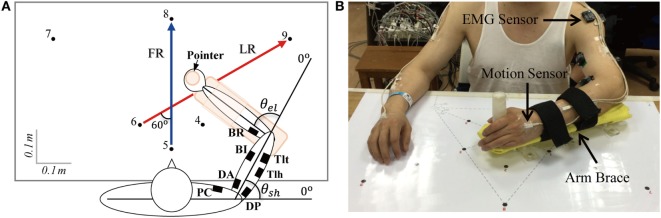
(A) Forward reaching (FR) and lateral reaching (LR) tasks and (B) experimental set up. Subjects moved the pointer from point 5 to point 8 when performing FR and from point 6 to point 9 for LR when the right arm was evaluated (point 4 to point 7 when the left arm was evaluated). Seven channels of electromyography (EMG) were recorded with wireless EMG sensors indicated by filled squares in (A), the recorded muscles were pectoralis clavicular (PC), anterior deltoid (DA), posterior deltoid (DP), biceps (BI), triceps long head (Tlh), Brachioradialis (BR), and triceps lateral head (Tlt). θel and θsh are the angles of elbow and shoulder joints. Signals of position were collected by seven motion sensors (B), and they were put on bilateral upper arms, forearms, palms, and thorax (back of neck).